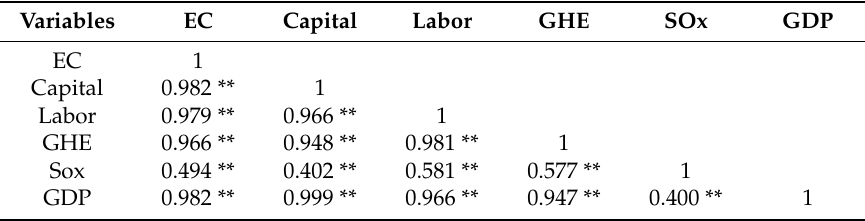
Table 5. Pearson correlation coefficients of input and output variables for 2006–2013.